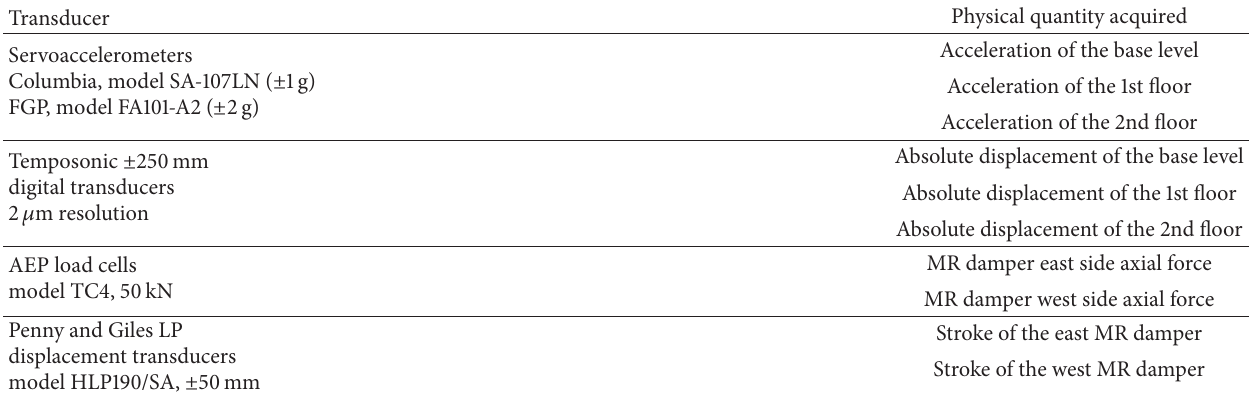
Table 1: Acquisition of the structural response for the case study